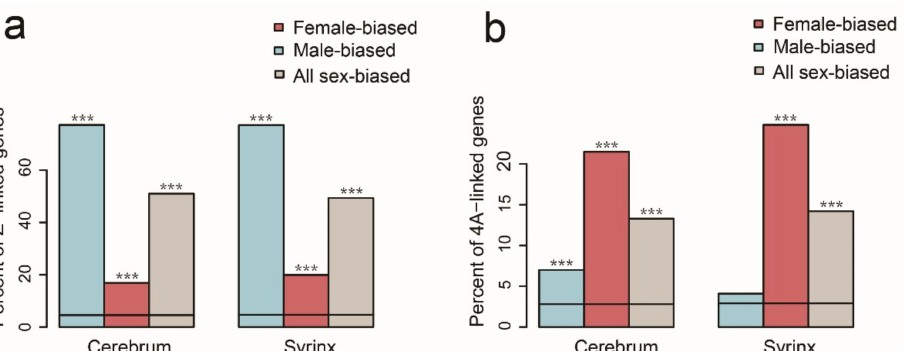
Figure 2. Chromosome enrichment of sex-biased genes: Z chromosome enrichment of sex-biased genes ( a ); and 4A chromosome enrichment of sex-biased genes ( b ). The predicted percentage of sex-biased genes on chromosome Z or 4A (horizontal black solid lines). The actual percentage of sex-biased genes on chromosome Z or 4A (vertical bars). Significant difference is represented by *, using Fisher’s exact test, * p < 0.05, ** p < 0.01, *** p <